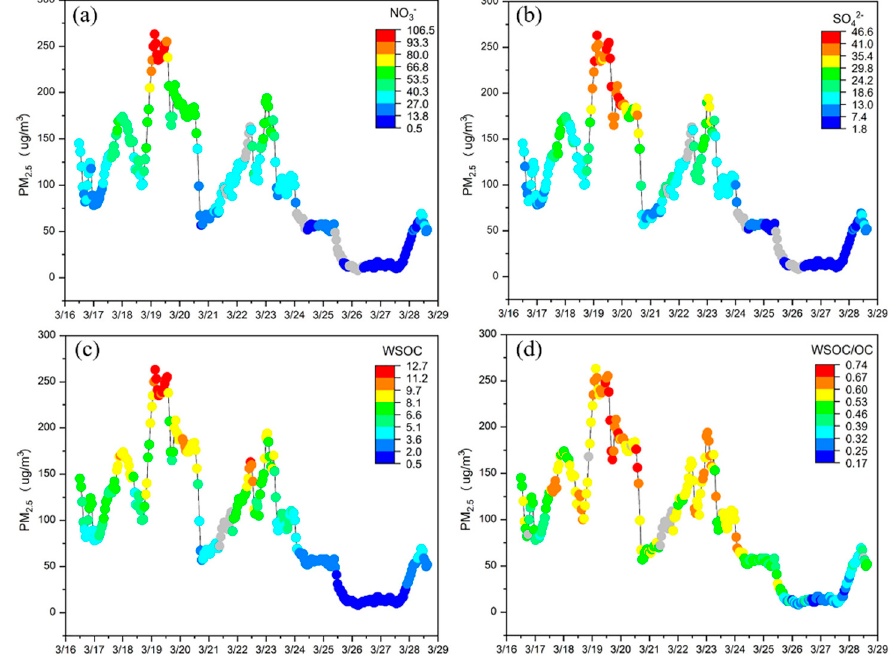
Figure 6. Temporal variation of PM 2.5 colored by ( a ) NO 3 − , ( b ) SO 42 − , ( c ) WSOC, and ( d ) the WSOC / OC ratio during the study period. Note: gray dots represent missing data.